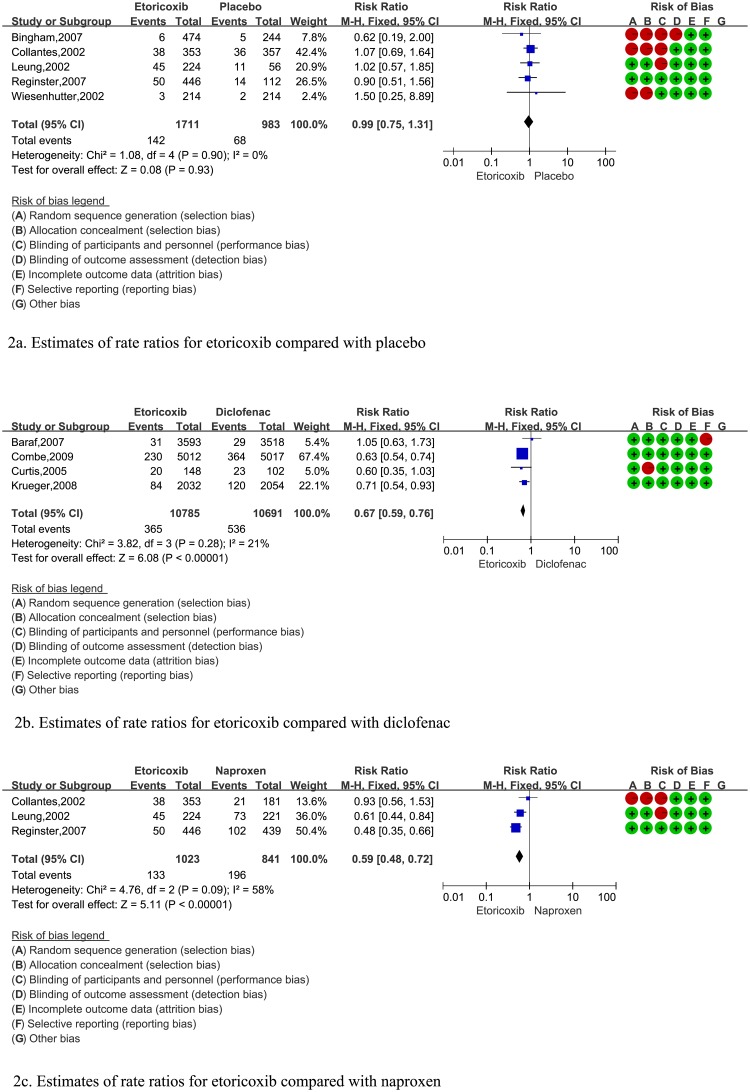
Forest plot of estimates of rate ratios for etoricoxib compared with placebo, diclofenac, and naproxen.